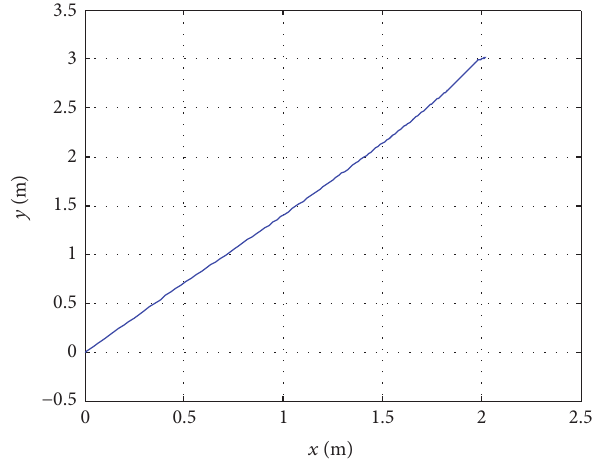
Figure 6: Ship horizontal motion with environmental disturbances.